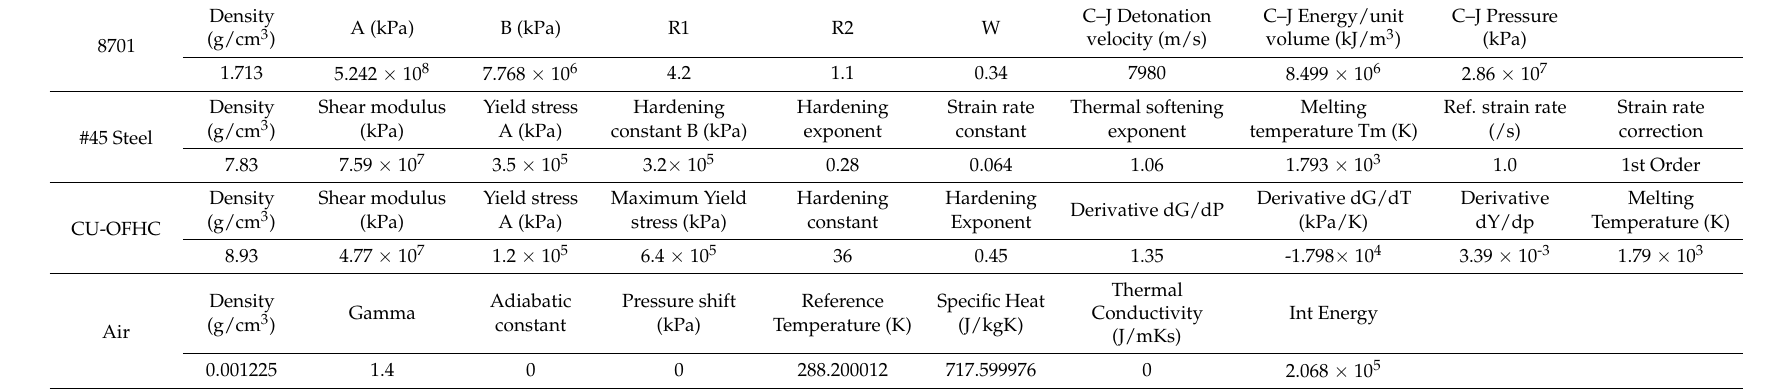
Table 2. Parameters of material